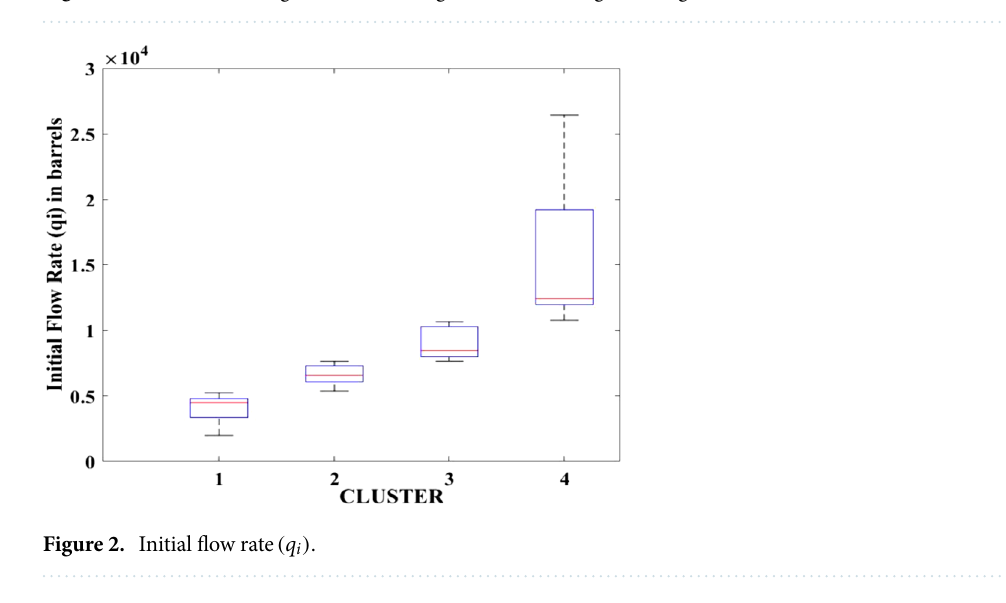
Figure 1. Bakken Shale region with oil and gas wells (natural gas intelligence) 17 .